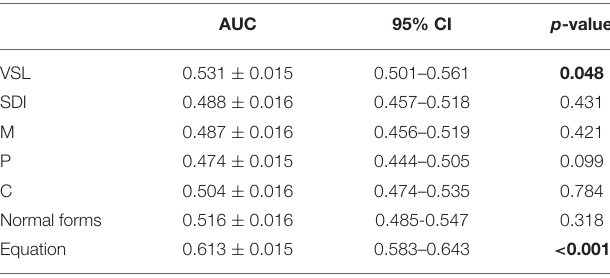
TABLE 4 | ROC curve analysis of the influencing factors for AIH pregnancy. TABLE 5 | ROC curve analysis of the clinically acceptable cut-off